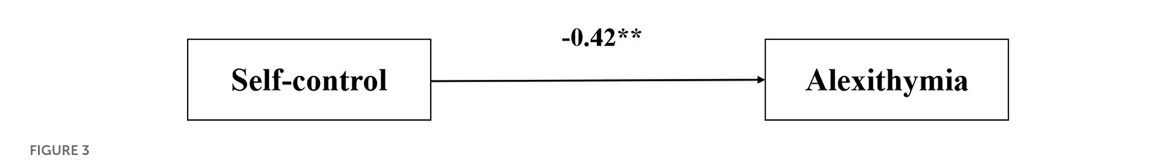
FIGURE3 Standardized solutions for the structural equation model of self-control and